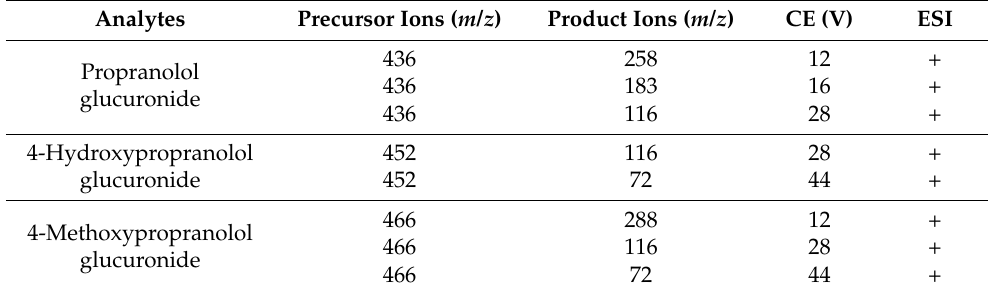
Table 2. The presented peak areas were provided by transitions of the highest intensity. Table 2. Transitions for all analytes in